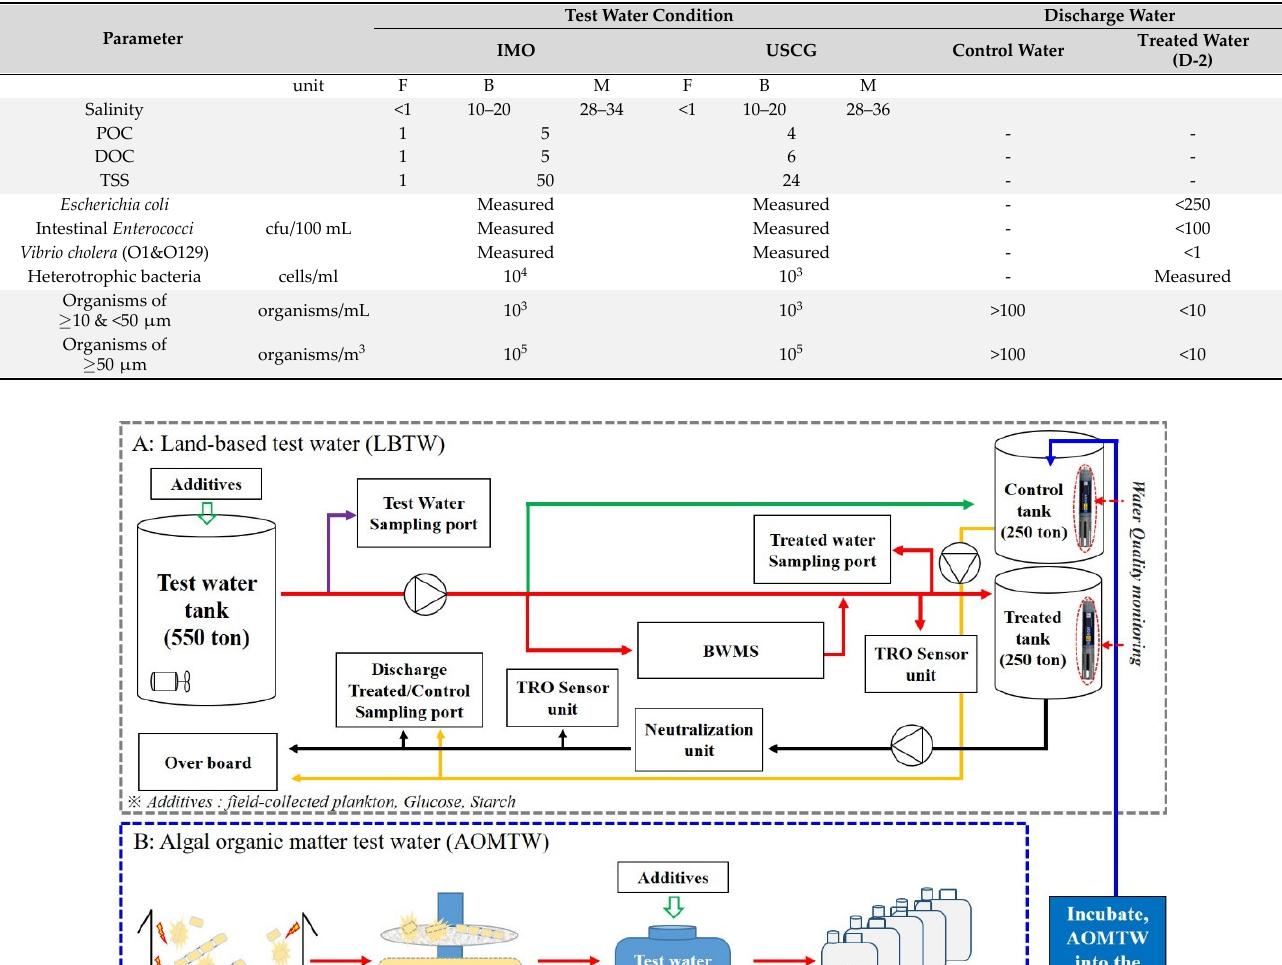
Table 1. Minimum criteria for land‑based (LB) IMO (BWMS code) and USCG (ETV protocol) require‑ ments (freshwater: F; brackish water: B; marine water: M).